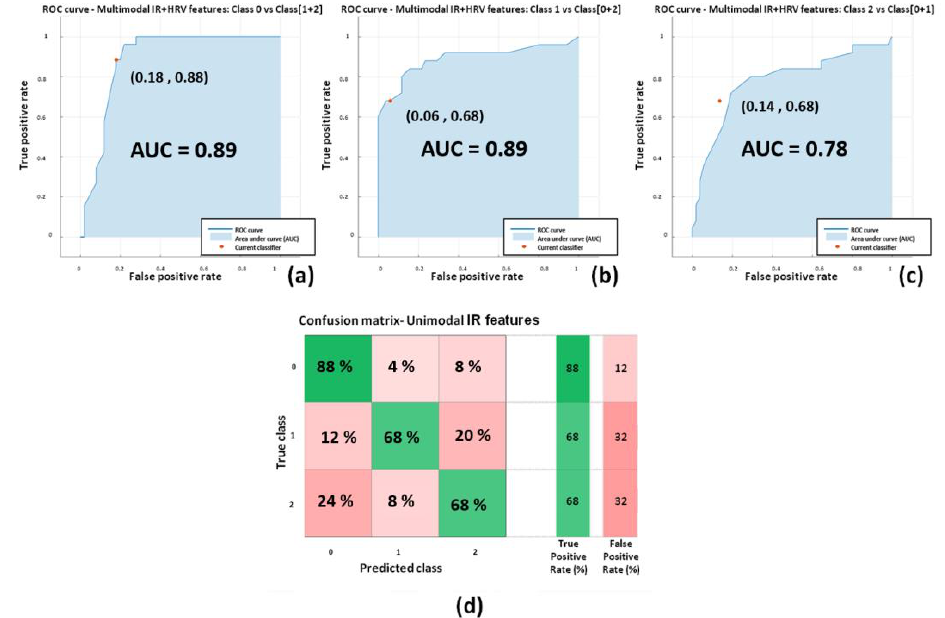
Figure 15. Performances of the Ensemble bagged trees for multimodal IR + hrv features-based classifiers for RAVLT: ( a ) ROC curve for the classifier of class ImmR (i.e., class 0) vs. cumulative class (DelR + Rec) (i.e., class 1 + 2); ( b ) ROC curve for the classifier of class DelR (i.e., class 1) vs. cumulative class (ImmR + Rec) (i.e., class 0 + 2); ( c ) ROC curve for the classifier of class Rec (i.e., class 2) vs.